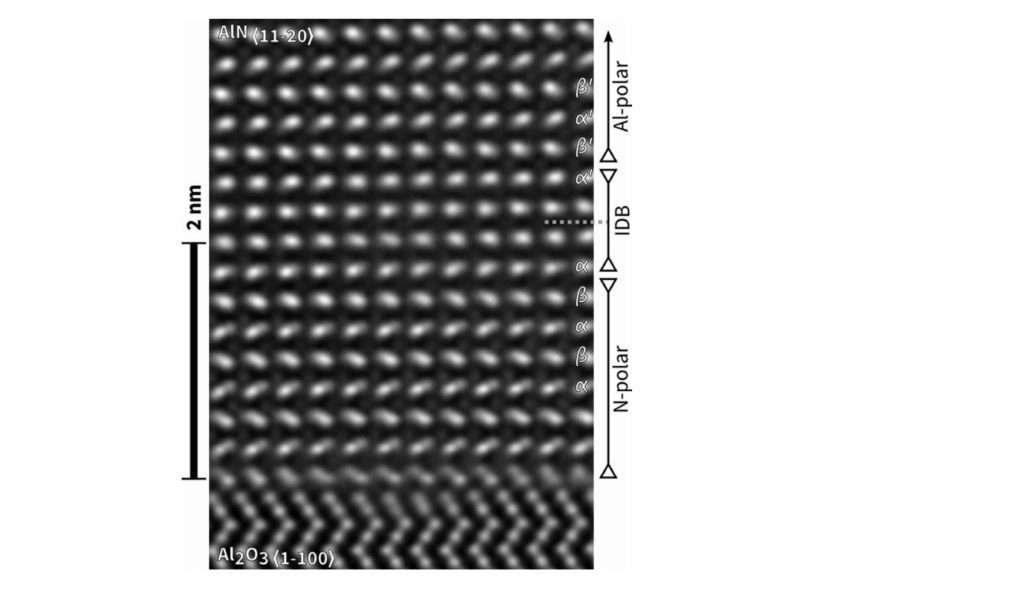
Figure 3. Cross-sectional HRTEM image of AlN/sapphire template. The polarity of AlN epilayer evolved from N-polar to Al-polar within 3 nm above the AlN/sapphire interface. Reprinted from [31] under the terms of the Creative Commons Attribution 3.0 License.